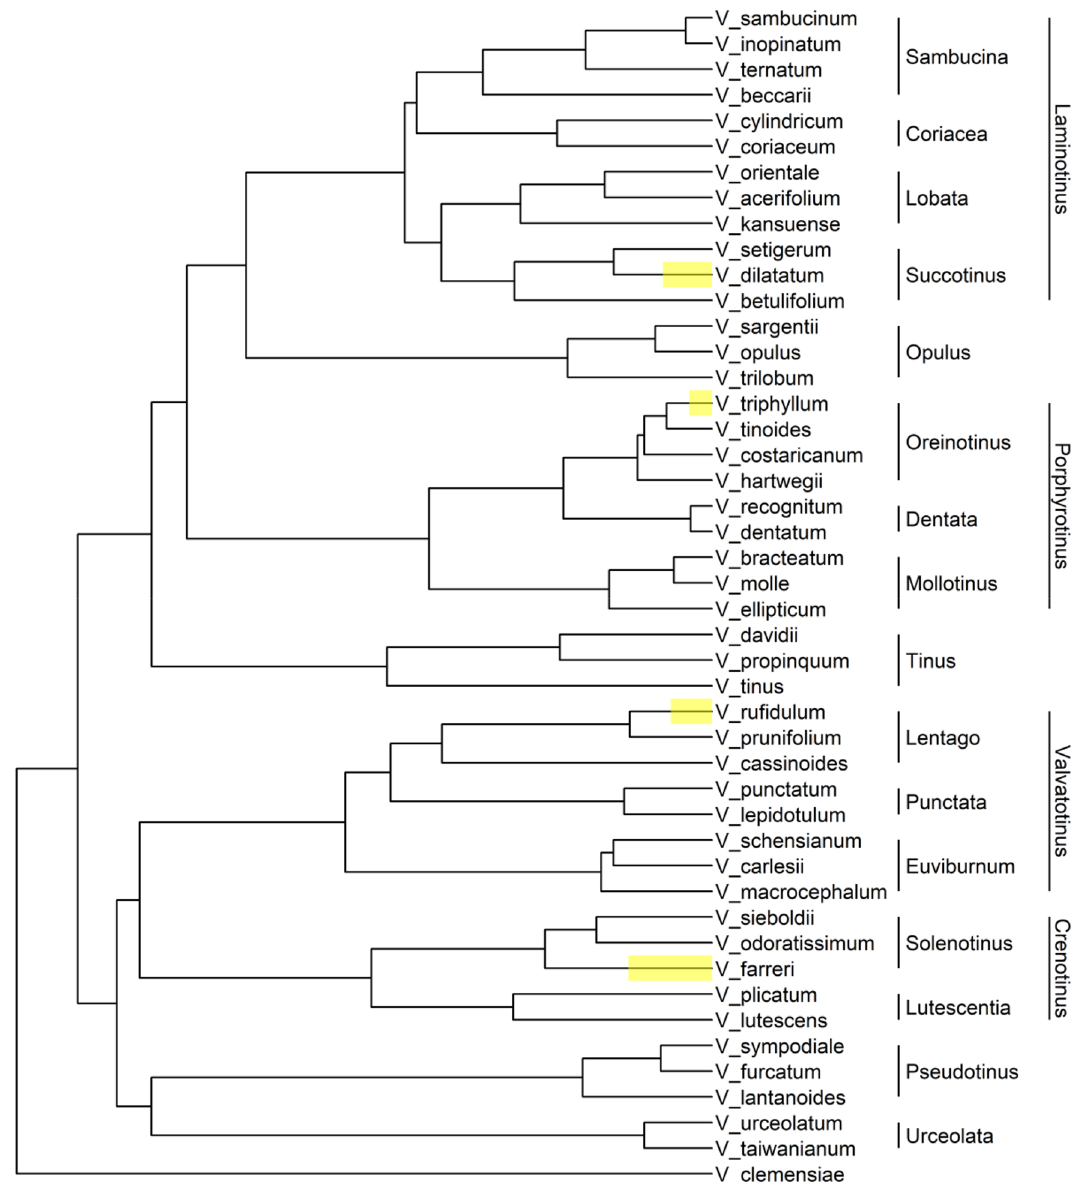
Figure 1. Phylogenetic tree of Viburnum species included in this study. This tree is a trimmed version of the one published in Landis et al. 1 based on RAD-seq data. Highlighted nodes are species in which simple sequence repeat (SSR) markers were developed. Subclades are horizontal and major clades are